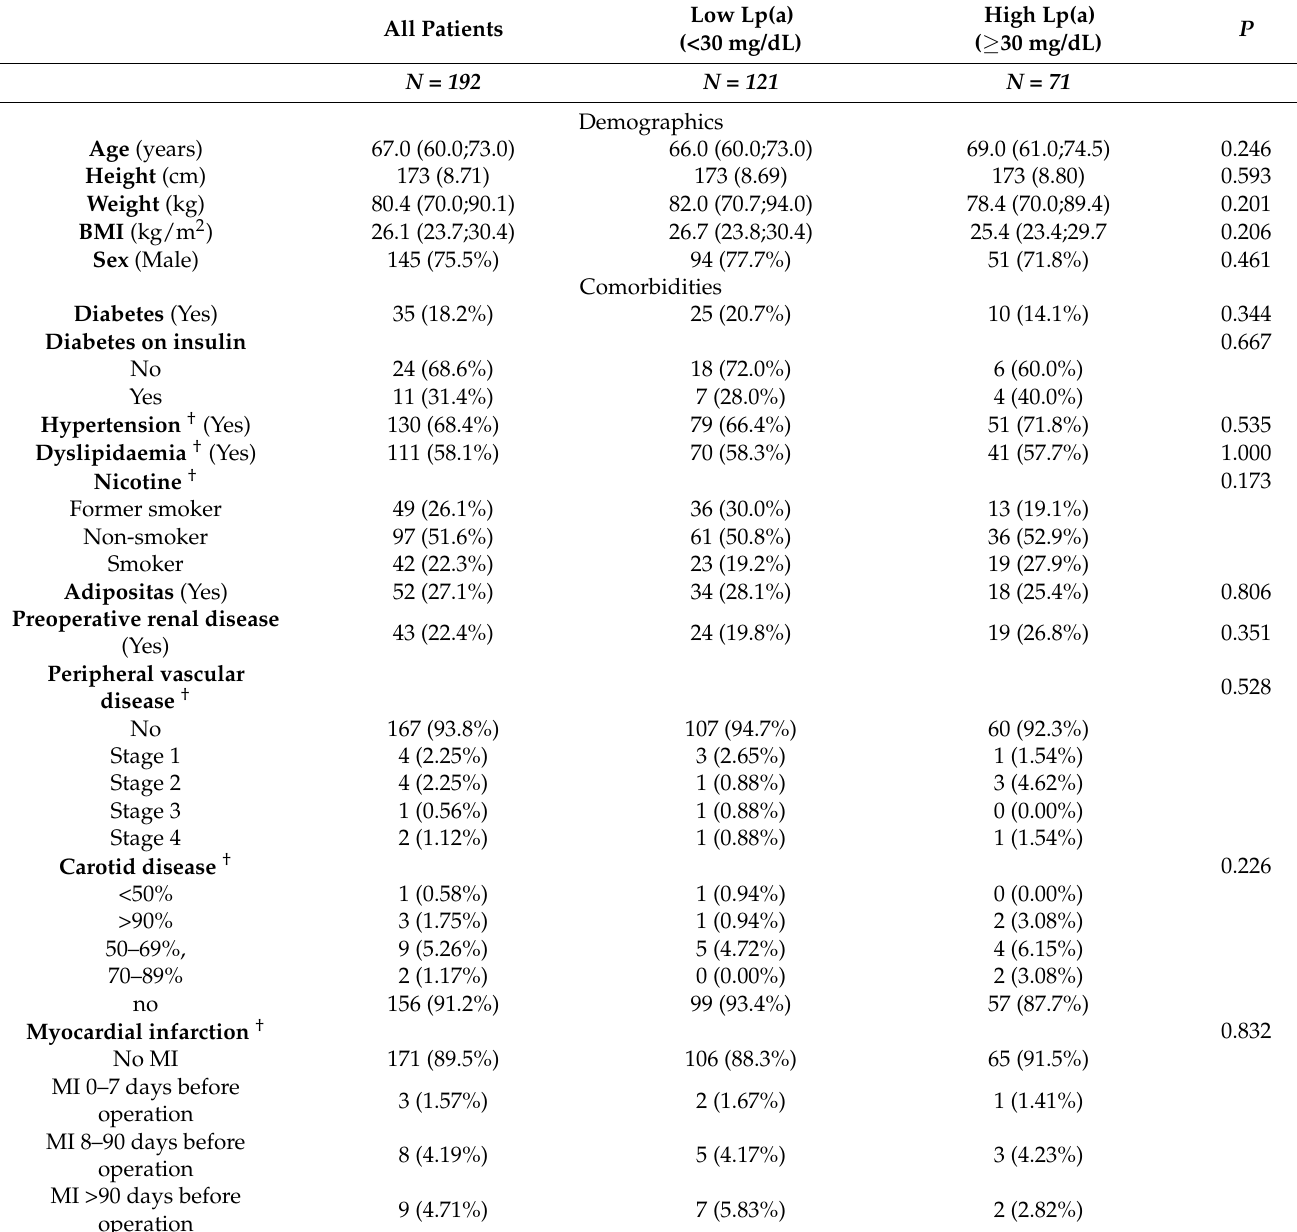
Table 1. Baseline characteristics grouped by preoperative